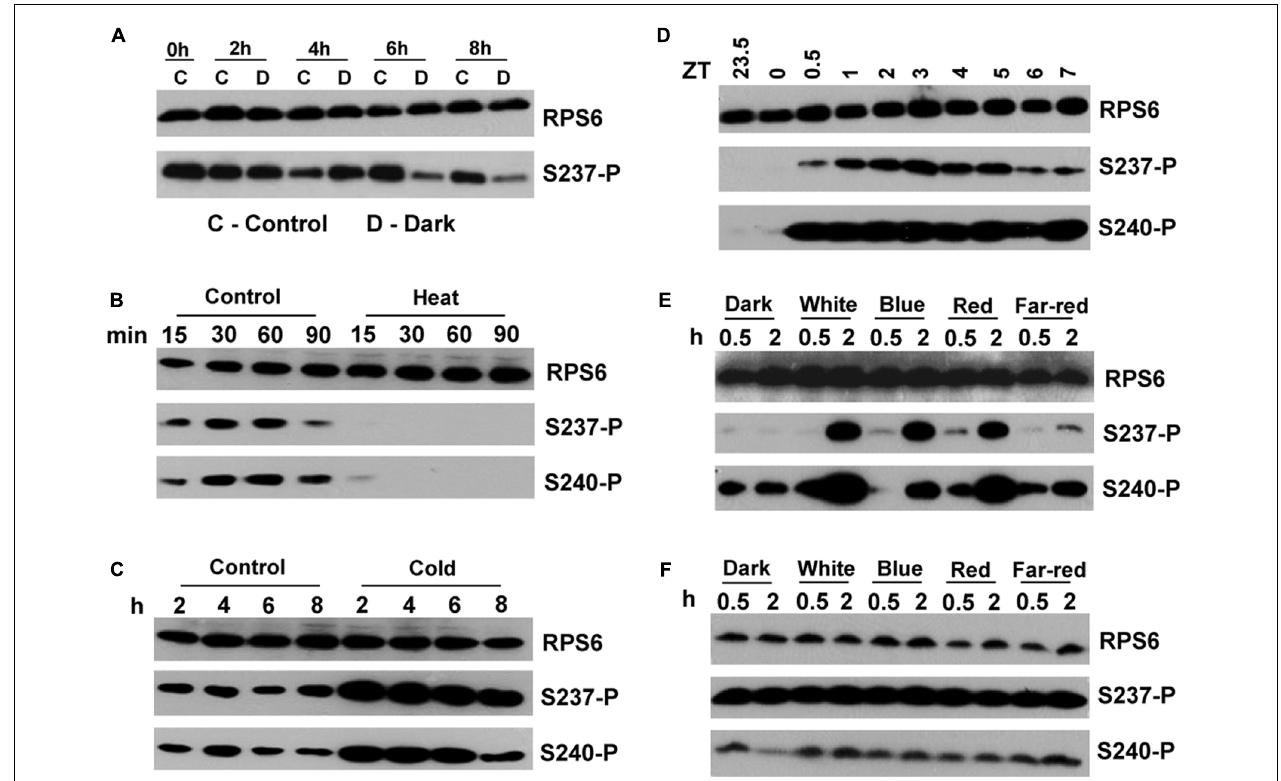
FIGURE 5 | Acute responses of RPS6-phosphorylation to light and darkness, heat and cold. All seedlings are wild-type and 12-days-old. Experiments were replicated twice with similar results. (A) Seedlings grown in a LD cycle on 1% sucrose were shifted to darkness at ZT 4 for the indicated times. Control seedlings were maintained in the light. (B) Seedlings grown in a LD cycle on 0% sucrose were subjected to 37 ◦ C heat in the light for the indicated times. (C) Seedlings grown in a LD cycle on 0% sucrose were subjected to 4 ◦ C in the light for the indicated times. (D) Seedlings grown in a LD cycle on 1% sucrose were transferred to white light for the indicated times. (E) Etiolated seedlings germinated in darkness without sucrose were exposed to the indicated light qualities for 0.5 or 2 h. (F) Same as (E) but in the presence of 1% sucrose. Note that levels of phosphorylation were elevated even in darkness. Absolute signal strength should not be compared with that in other panels because exposure times for the immunoblots